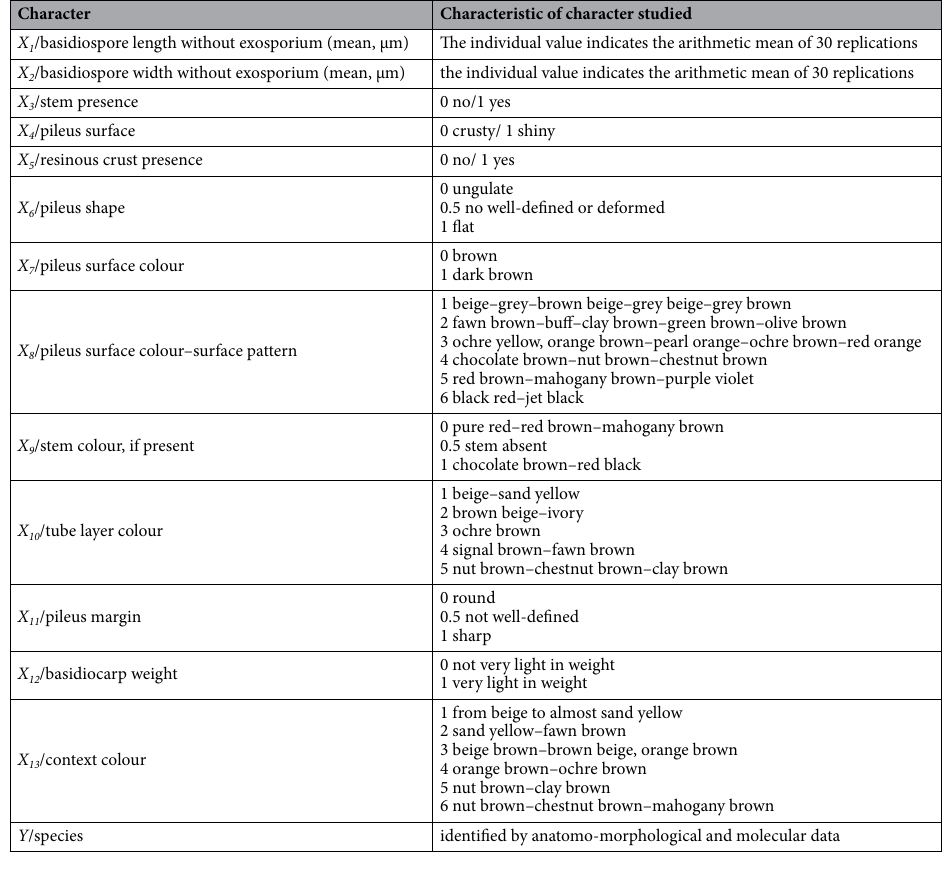
Table 1. Summary table of characters and characteristics of the studied Ganoderma